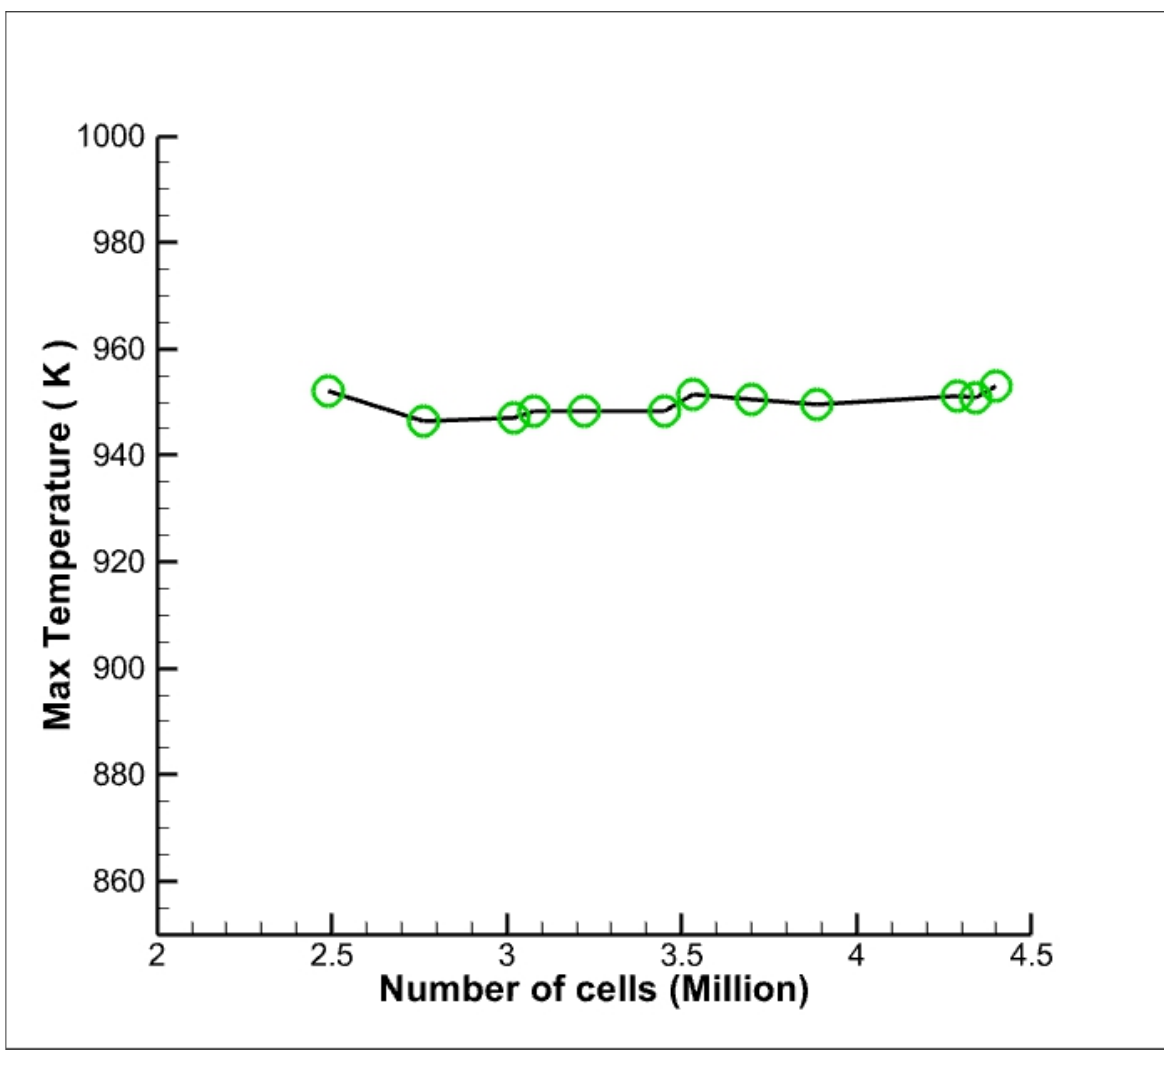
Figure 4. Grid independency